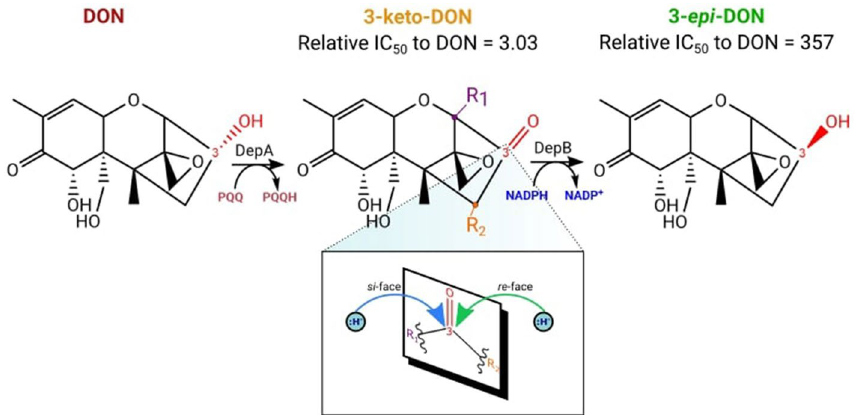
Figure 1. The Dep pathway. The C3 OH group of DON (shown in red) is stereochemically inverted to produce the diastereomer, 3- epi -DON. In the expanded image of this stereogenic center, R 1 and R 2 represent the priority groups attached to the sp 2 hybridized C3. Hydride attack on the re -face at the prochiral C3 center generates 3- epi